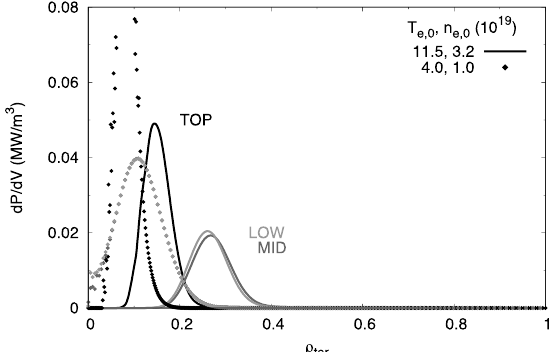
Fig. 10. Power deposition profile for different T e,0 , n e scaling (T e,0 in keV, n e,0 in m -3 ) .